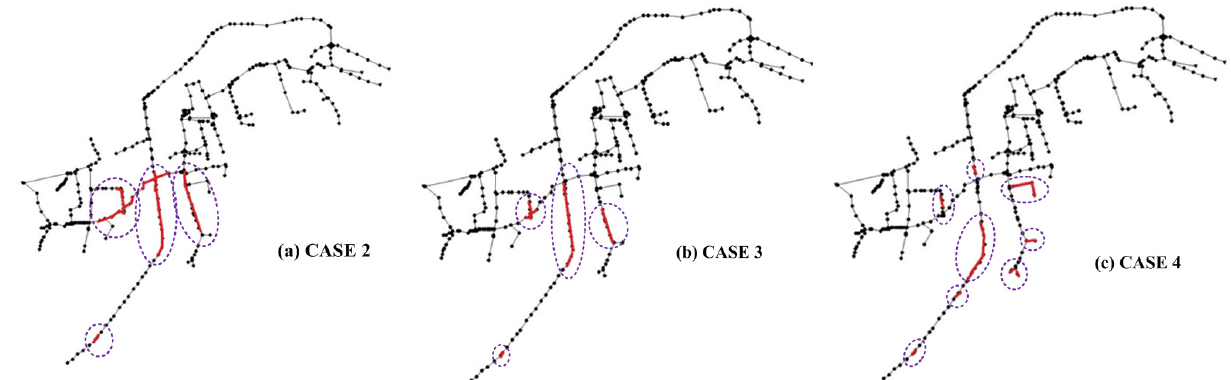
Figure 5. Spatial arrangement of regular design of rainwater harvesting